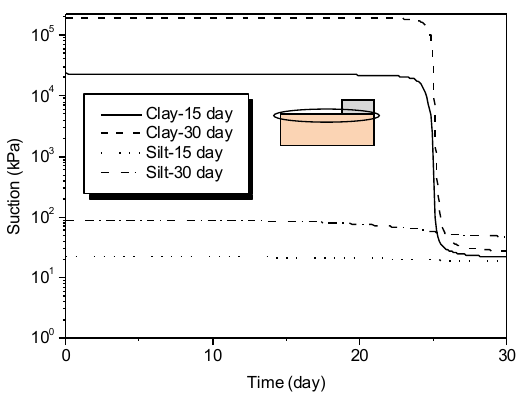
Figure 13d . Influnce the soil type on the variation of the suction at the soil surface